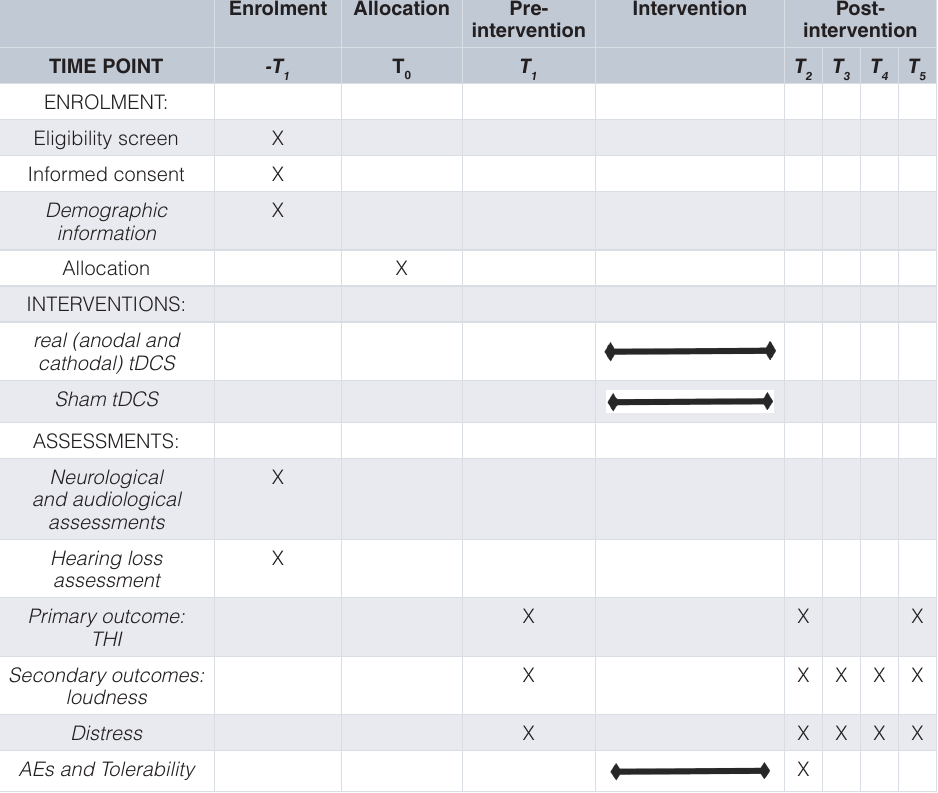
Table 2. Standard Protocol Items: Recommendations for Interventional Trials of this study. Enrolment Allocation Pre-